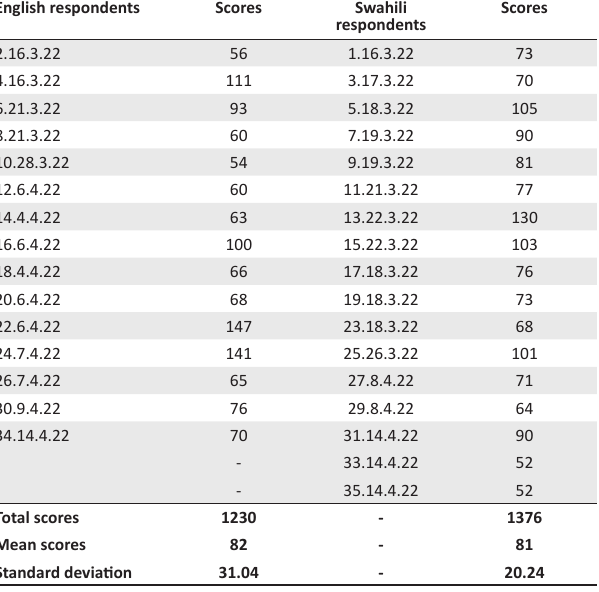
TABLE 5: Respondents scores on SSQOL(E) and SSQOL(S) ( N = 32).